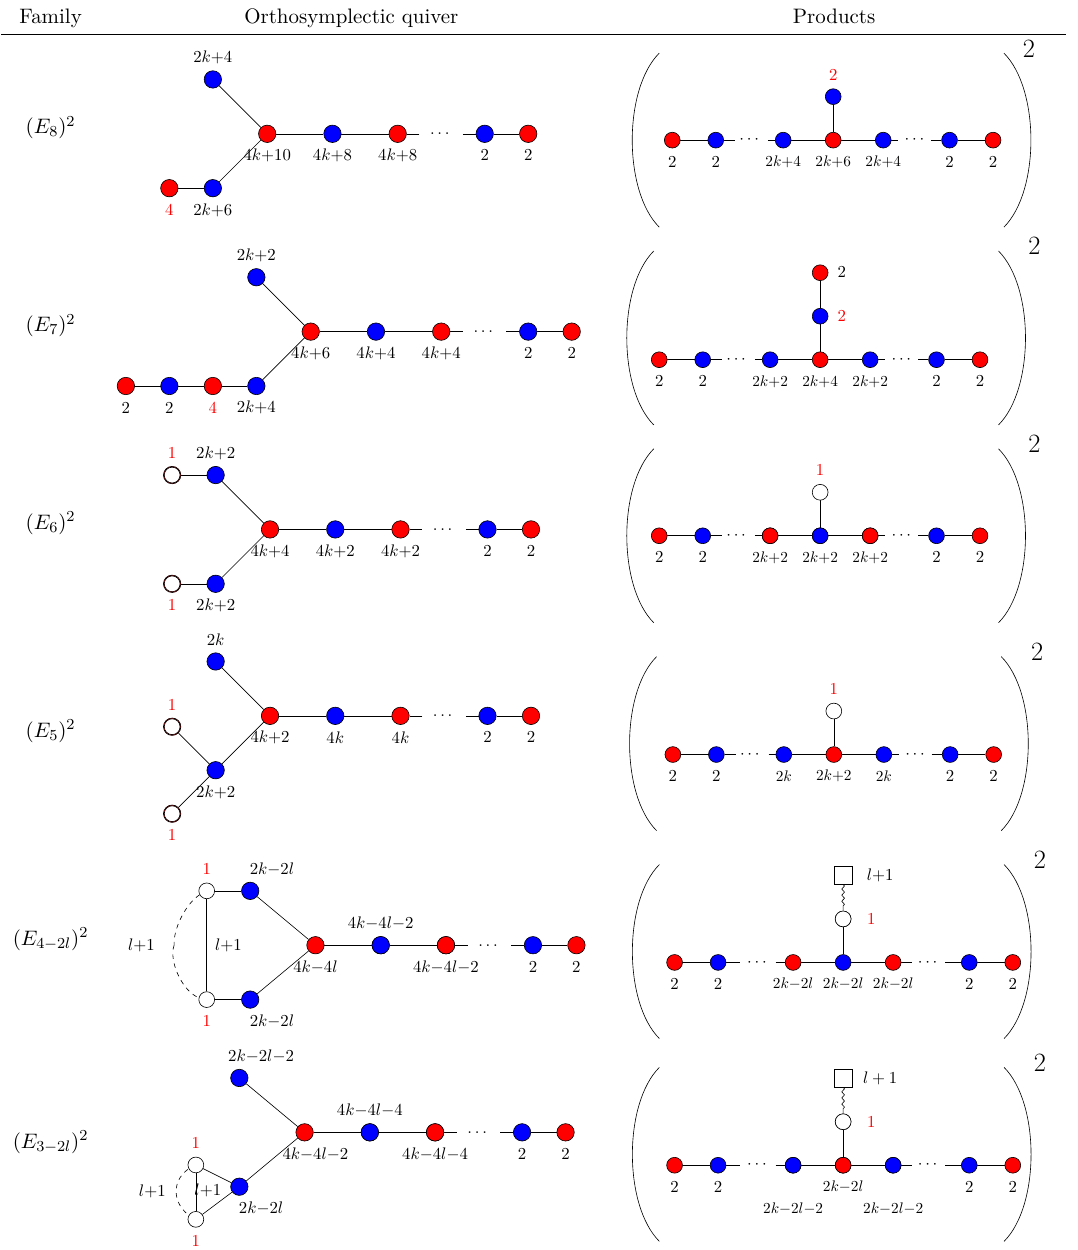
Table 4. The extended infinite families of the orthosymplectic quivers in table 3. The Coulomb branch of the forked orthosymplectic quivers on the left are the same as the Coulomb branch of prod- uct theories on the right. The numbers coloured in red represent gauge nodes that are